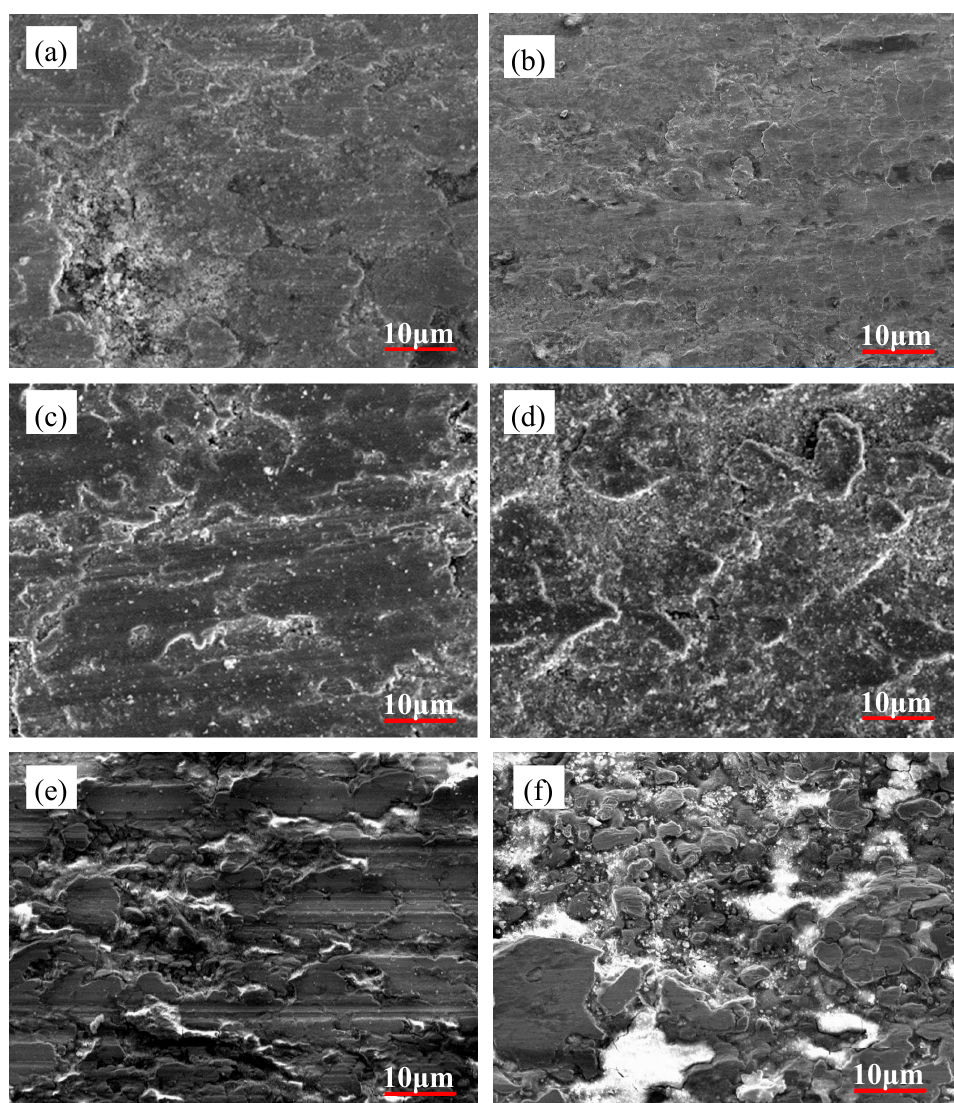
Figure 7. Wear-surface morphologies of the NiCr/hBN self-lubricating composites under different friction conditions: ( a ) 8% hBN, 25 °C; ( b ) 10% hBN, 25 °C; ( c ) 10% hBN, 600 °C; ( d ) 12% hBN, 600 °C; ( e ) 10% hBN, 800 °C; and ( f ) 12% hBN, 800 °C.